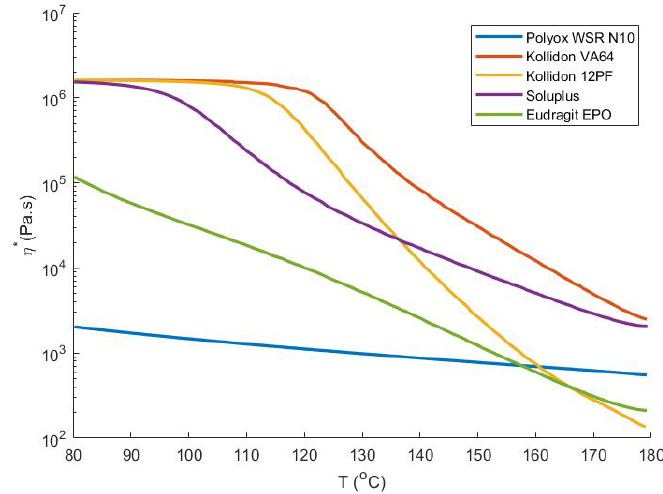
Figure 7. Complex viscosity as a function of temperature during a temperature